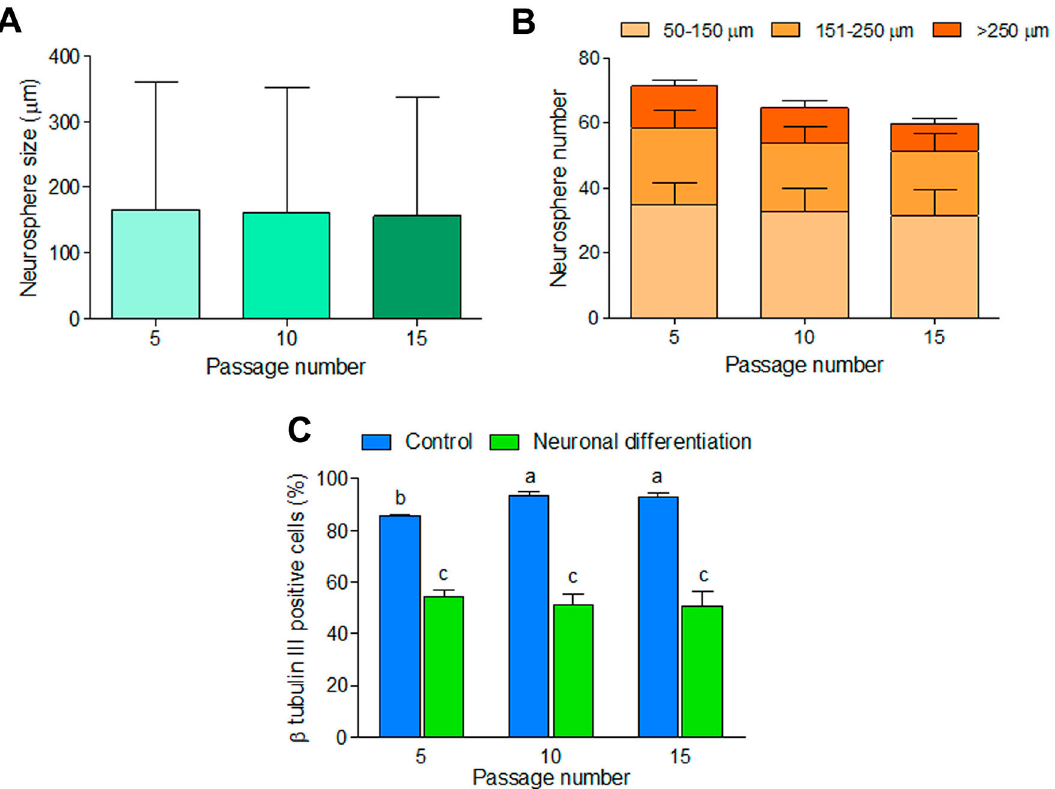
Figure 5- Effect of passage number of DPSCs on neurosphere formation and neuronal differentiation. (A) Average size, (B) average number, and (C) percentage of β tubulin III-expressing cells derived from DPSCs at passage 5, 10, and 15 after cultured the cells in neuronal differentiation medium compared to control medium. Bars with different alphabets are significantly different